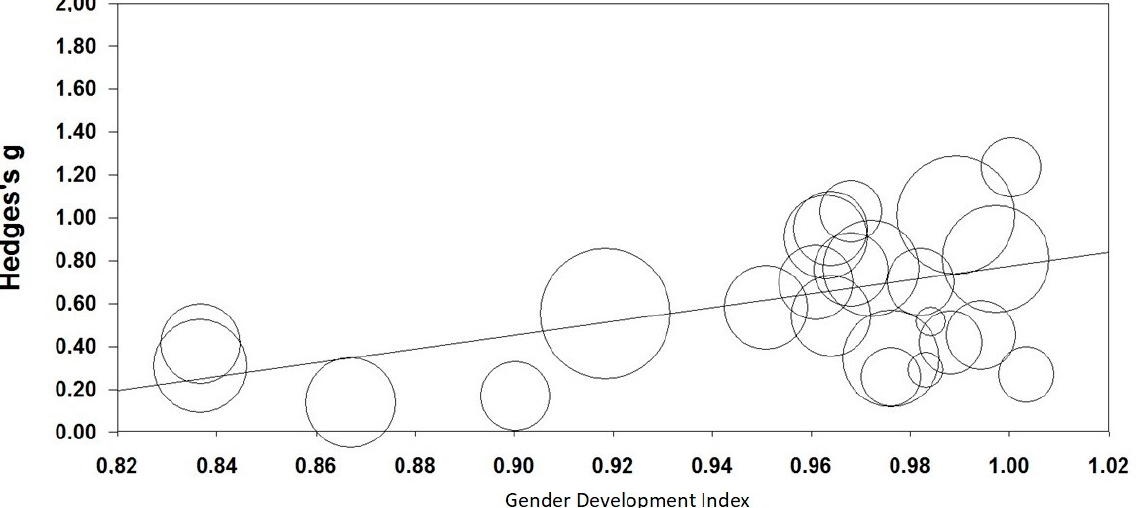
Figure 3. Relationship between gender development index and CRAS-S (AWA) scores. Higher scores of Hedge’s g represent a larger gender difference in the CRAS-S score and higher scores in Gender Development Index represent higher gender equality. Animal welfare attitudes (AWA) were measured with the Composite Respect for Animals Scale-Short Version (CRAS-S). Circles represent sample sizes.